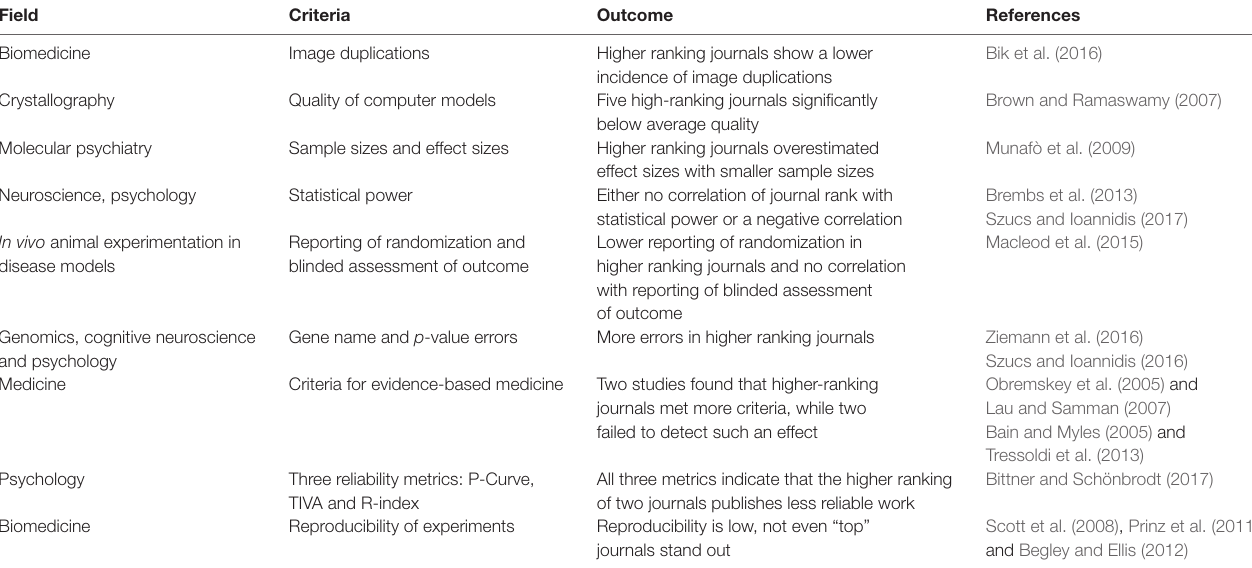
TABLE 1 | Overview of the cited literature on journal rank and methodological